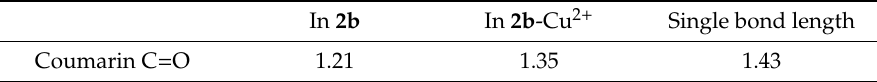
Table 4. Experimental and literature references of bond lengths (Å).